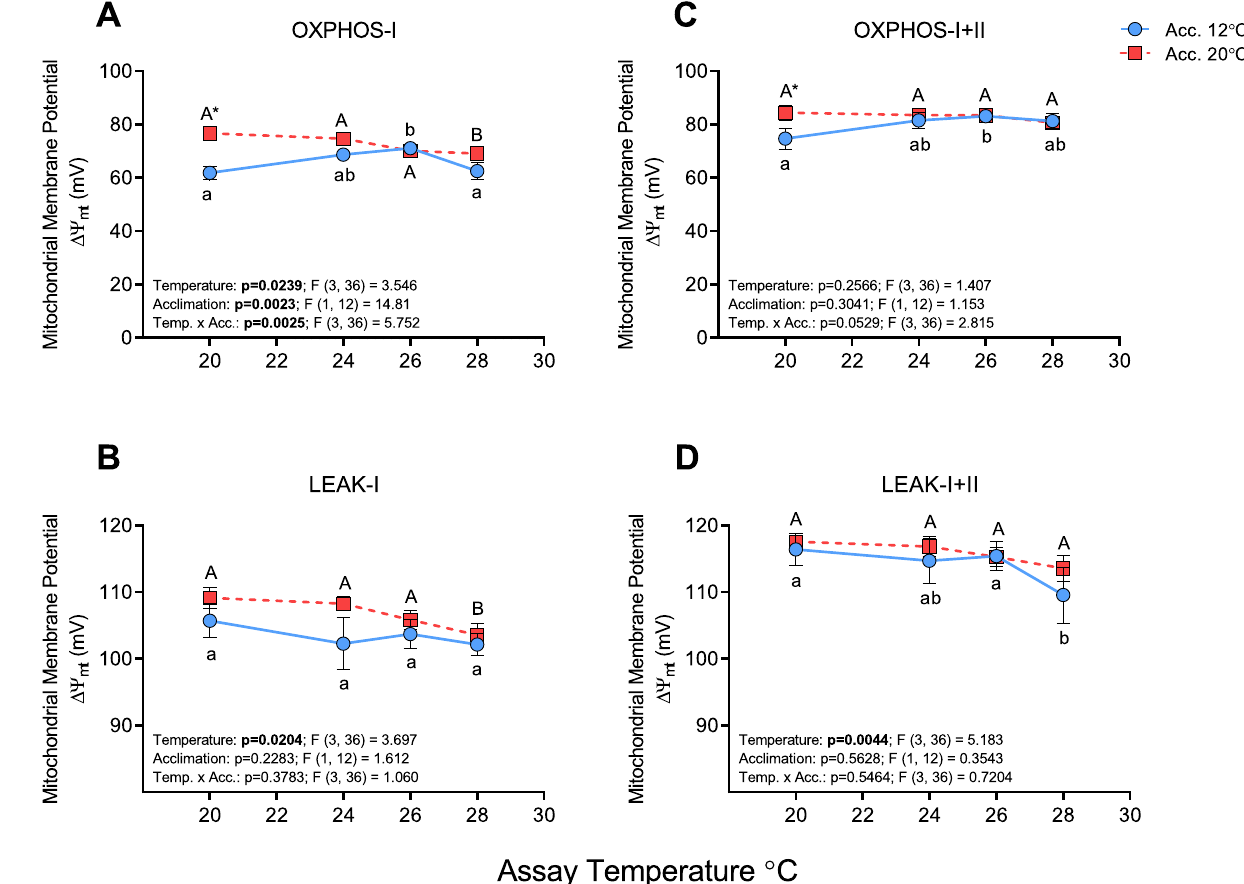
Figure 3. Membrane potential (ΔΨ mt ) in cardiac mitochondria from cold- (12 °C) and warm- (20 °C) acclimated salmon when measured at 20, 24, 26 and 28 °C. Mitochondrial membrane potential (ΔΨ mt ) was measured during oxidative phosphorylation (OXPHOS with ADP [100 μmol L −1 ]; A , C ) and LEAK ( B , D ) respiration through complex I ( A , B ; with glutamate and malate as substrates) and complexes I + II ( C , D ; with glutamate, malate and succinate as substrates). An asterisk (*) indicates a significant (P < 0.05) difference between acclimation groups within an assay temperature, whereas letters (a, A) indicate a significant difference between assay temperatures within an acclimation group. Values are means ± s.e.m., N = 7 per